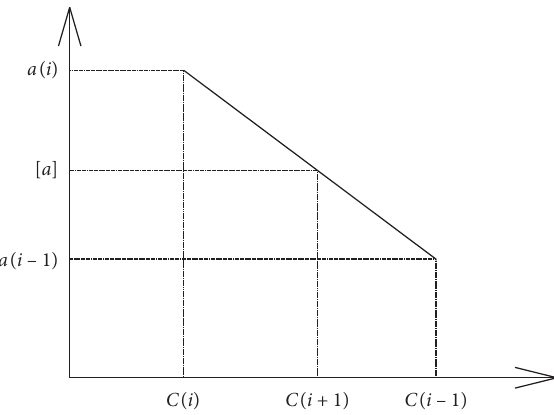
Figure 17: Damping coefficient-acceleration linear interpolation.